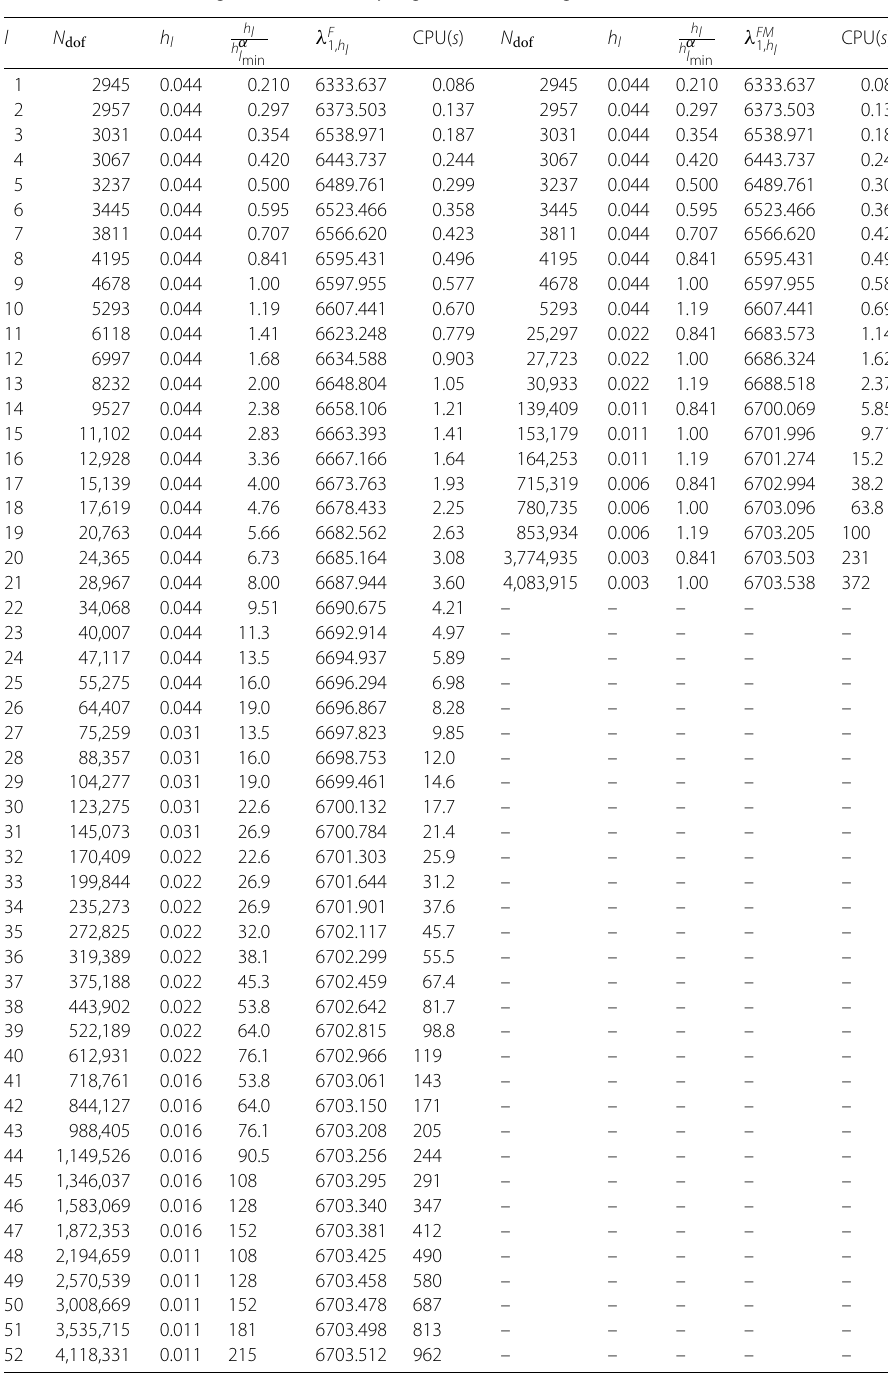
Table 3 The smallest eigenvalue solved by Algorithm 3 and Algorithm